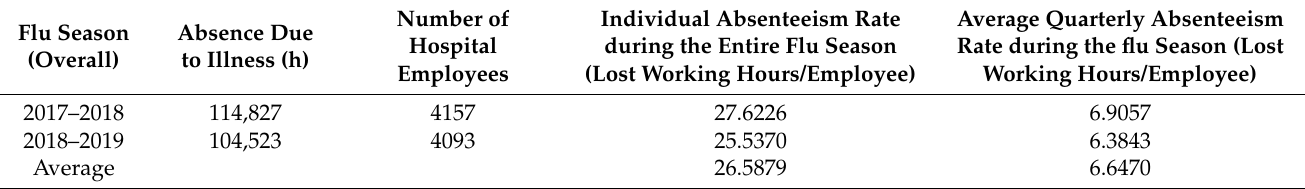
Table 4. Absence due to illness among hospital staff during the entire 2017–2018 and 2018–2019 flu seasons (calendar days).